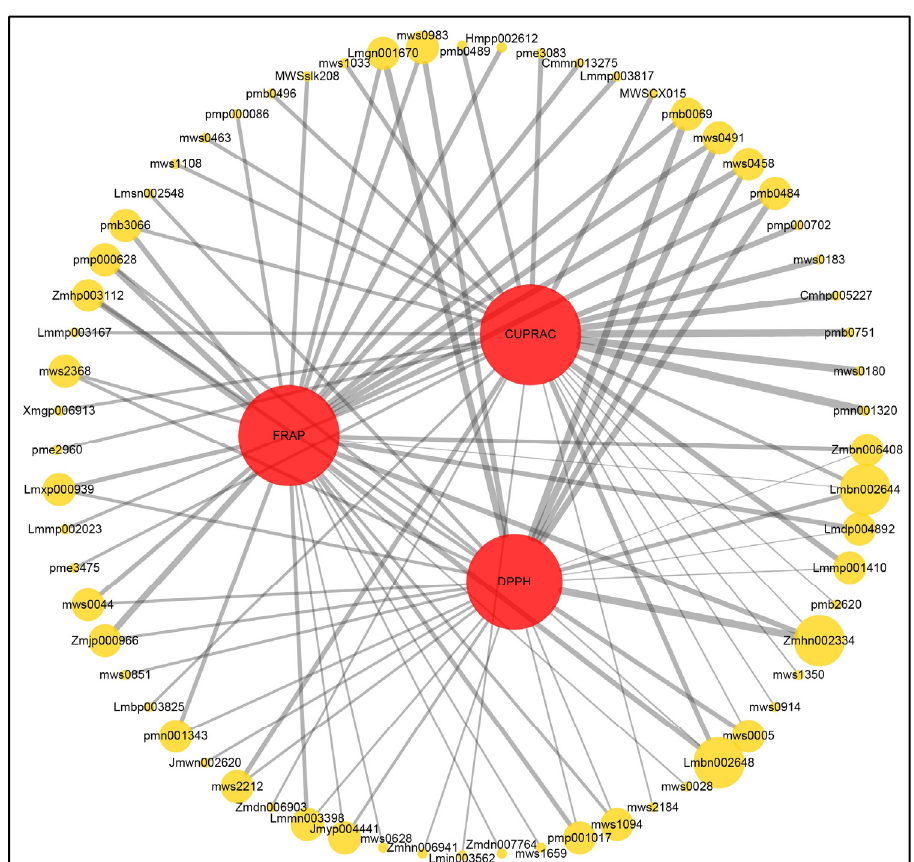
Figure 4. Network diagram between antioxidant capacity and metabolites. Red circles indicate d if- ferent antioxidant capacity (DPPH: 2,2-diphenyl-1-picrylhydrazyl radical scavenging ability; FRAP: ferric reducing antioxidant power; CUPRAC: cupricion reducing capacity.), yellow circles indicate different metabolites (The number above the circle indicates the component ID of Metware), and the line connecting the two circles represents the correlation, with the thicker the line the greater the correlation coefficient (r ≥ 0.9 and p < 0.0001).